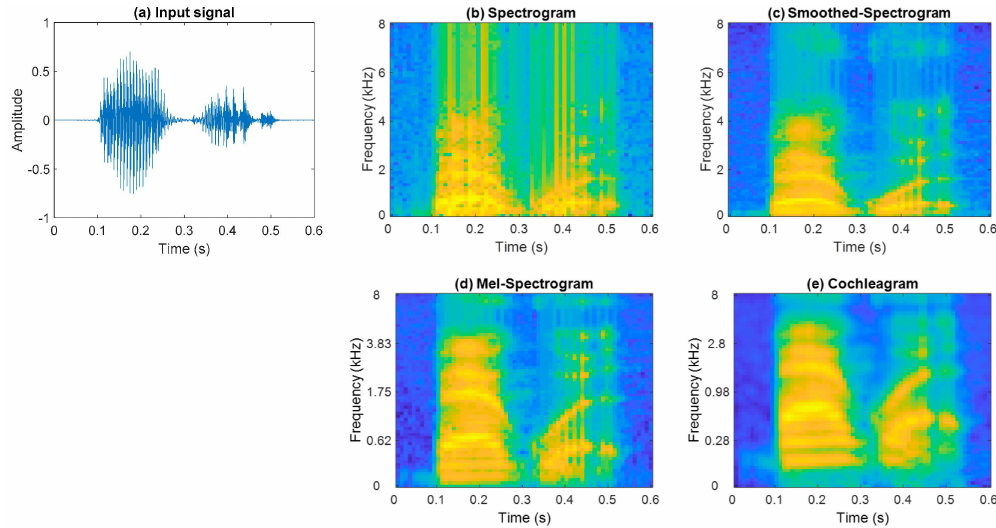
Figure 3. ( a ) Plot of the speech command signal backward and its time-frequency representations: ( b ) spectrogram, ( c ) smoothed-spectrogram, ( d ) mel-spectrogram, and ( e )